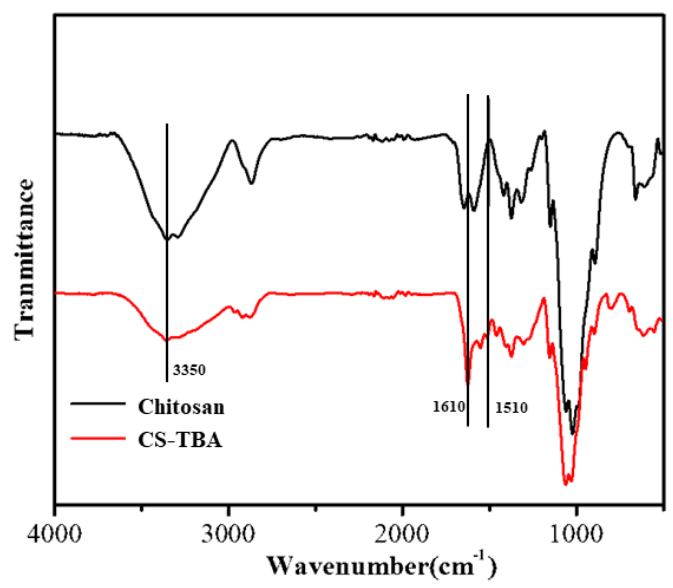
Figure 2. Infrared spectra of chitosan and CS-TBA polymer.